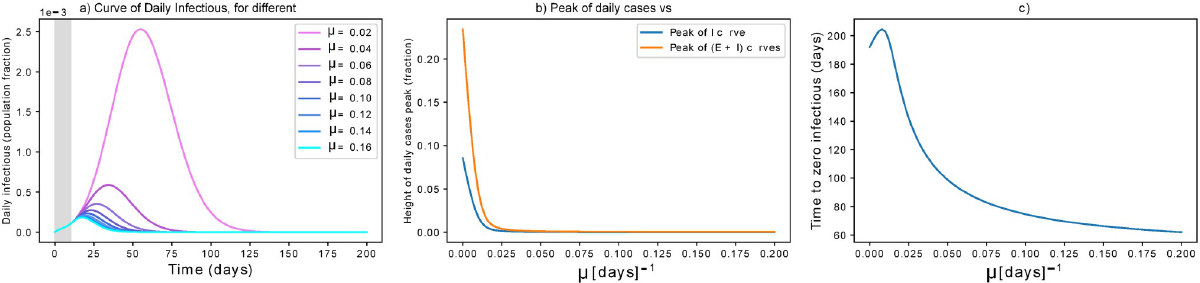
Fig 3. Effect of lock-down. (a) Effects of active protection on the infectious curve. The grey area indicates when measures are not yet in place. μ is expressed in d − 1 . (b) Dependency of peak height on μ : the peak is rapidly flattened for increasing μ , then it is smoothly reduced for higher parameter values. (c) High μ values are effective in anticipating the mitigation of the epidemic, but require protecting more than 90% of the population.